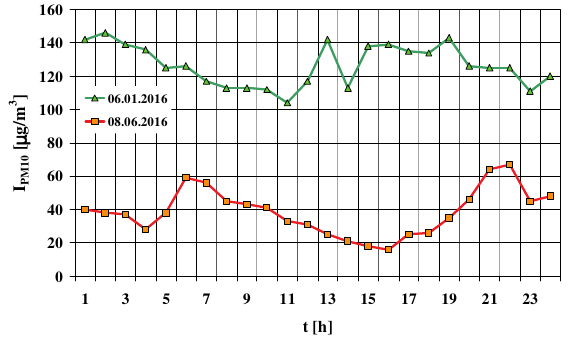
Fig. 4. The immission of particulate matter PM10 values obtained from Kraków–Dietla station on 6 January 2016 and 8 June